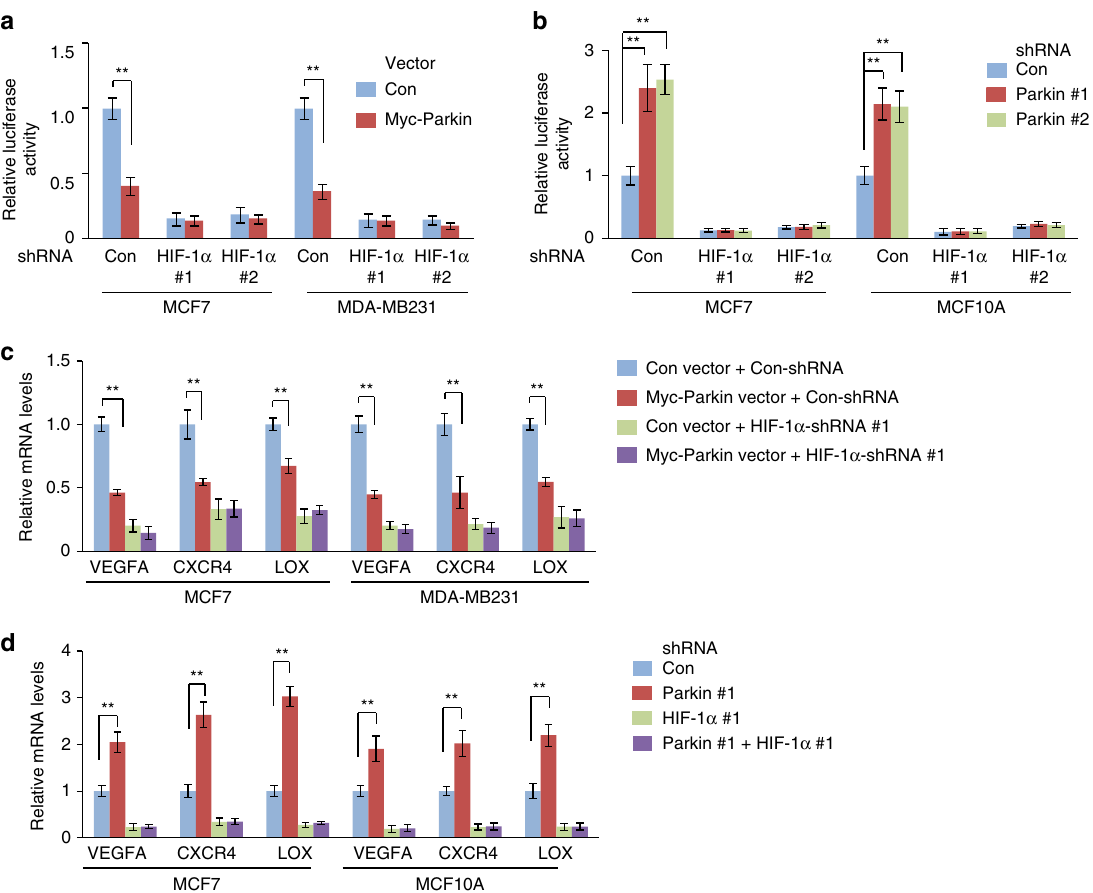
Fig. 3 Parkin negatively regulates HIF-1 α transcriptional activity. a Myc-Parkin expression inhibited HIF-1 α luciferase reporter activities in cells. b Parkin knockdown increased HIF-1 α luciferase reporter activities in cells. c Myc-Parkin expression reduced mRNA expression of HIF-1 α target genes in cells. d Parkin knockdown increased mRNA expression of HIF-1 α target genes in cells. Gene expression was measured by quantitative Taqman real-time PCR and normalized with actin . In c , HIF-1 α was knocked down by 2 different shRNA vectors, and in d , HIF-1 α and Parkin were knocked down by 2 different shRNA vectors. Similar results were observed for 2 different HIF-1 α and Parkin shRNA vectors, and only results from one shRNA vector were presented for the sake of clarity. The data present mean ± S.D. ( n = 6). ** P < 0.001; two-tailed Student's t